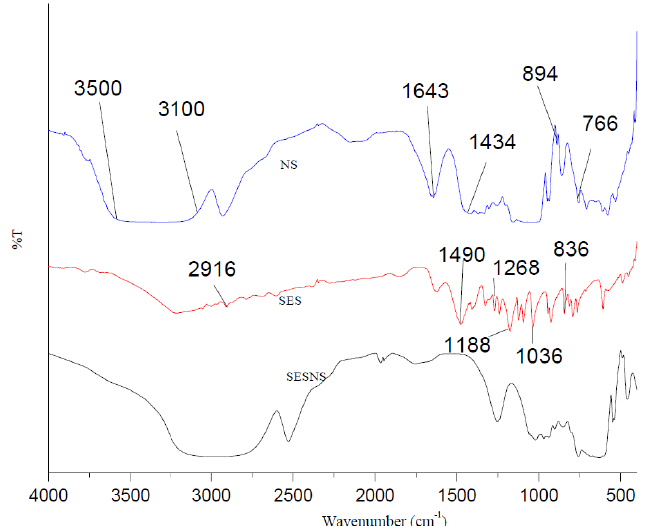
Figure 4. Fourier transform infrared spectra of blank nanosponges (NS), Sesamol (SES), and bioactive-loaded selected batch (SESNS).